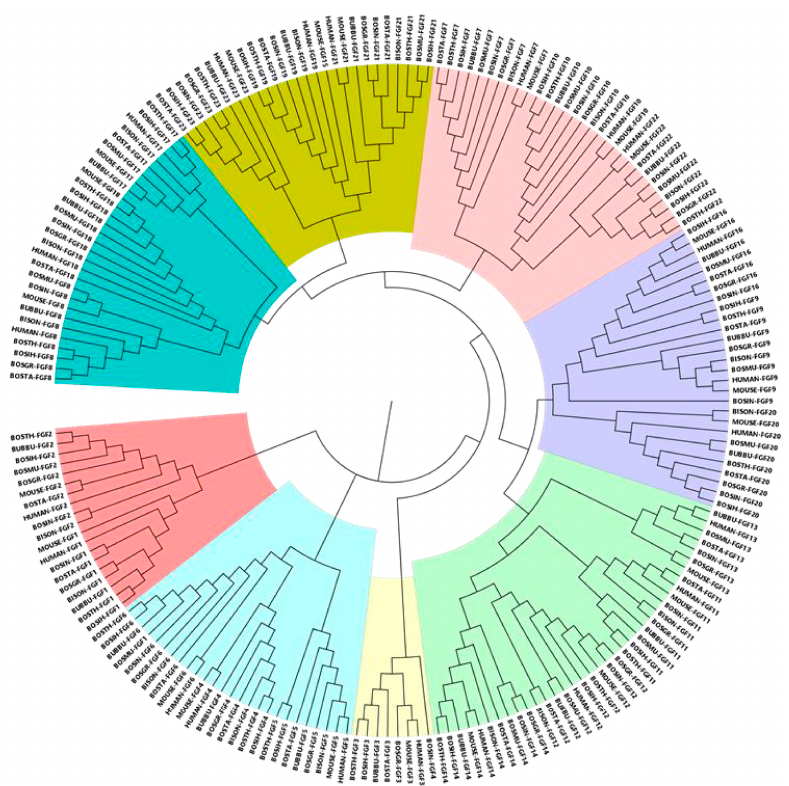
Figure 2. Phylogenetic neighbor-joining (NJ) tree of FGF family members of different species. FGF proteins were divided into eight clusters, which were distinguished by di ff erent colors.